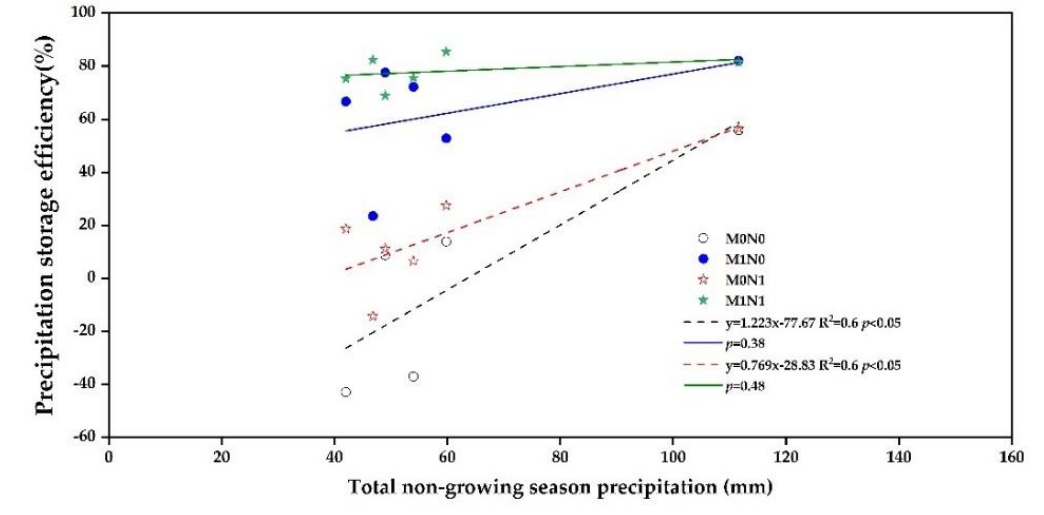
Figure 7. Linear relationship between precipitation and precipitation storage efficiency in the nongrowing season.